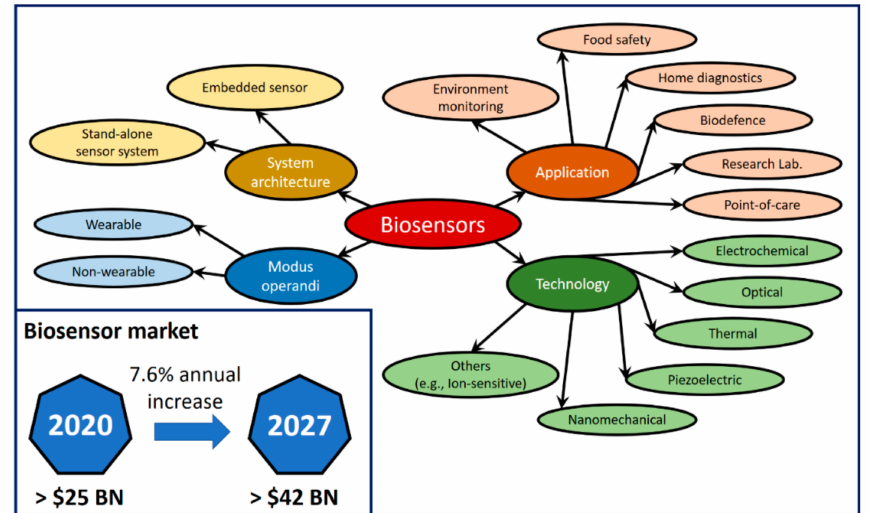
Figure 1. Biosensor’s insight and